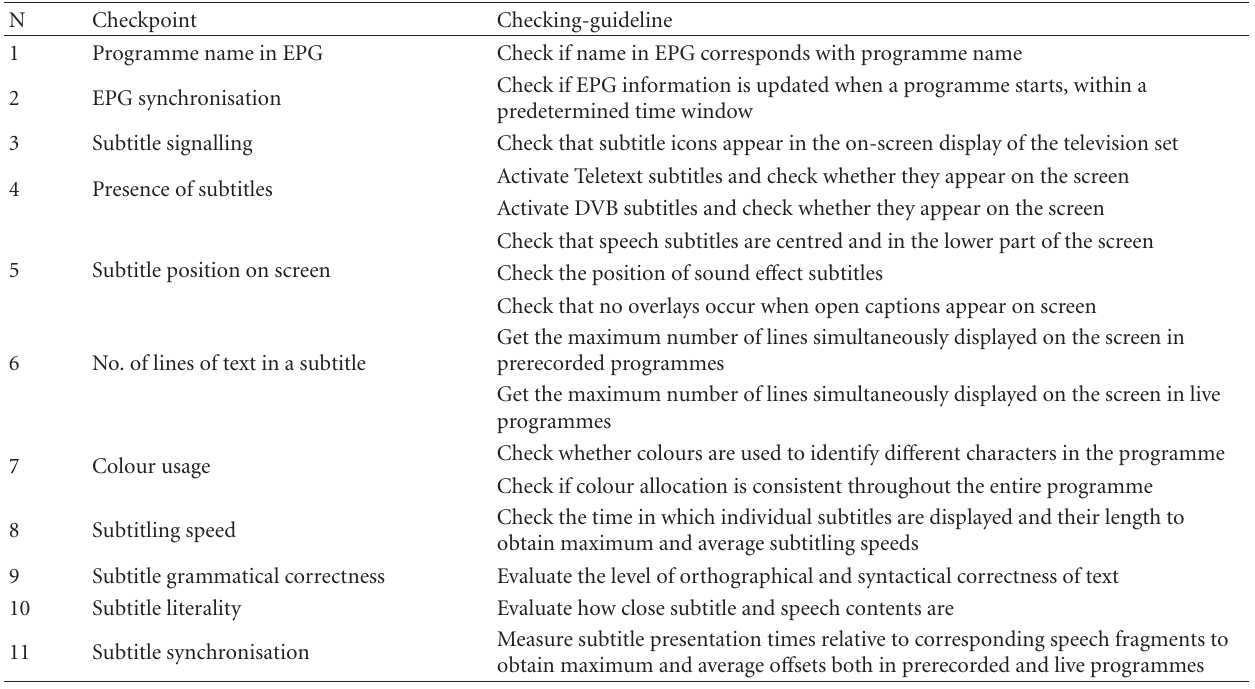
Table 1: Checklist of checkpoints and evaluation guidelines defined for the manual verification of subtitling in television